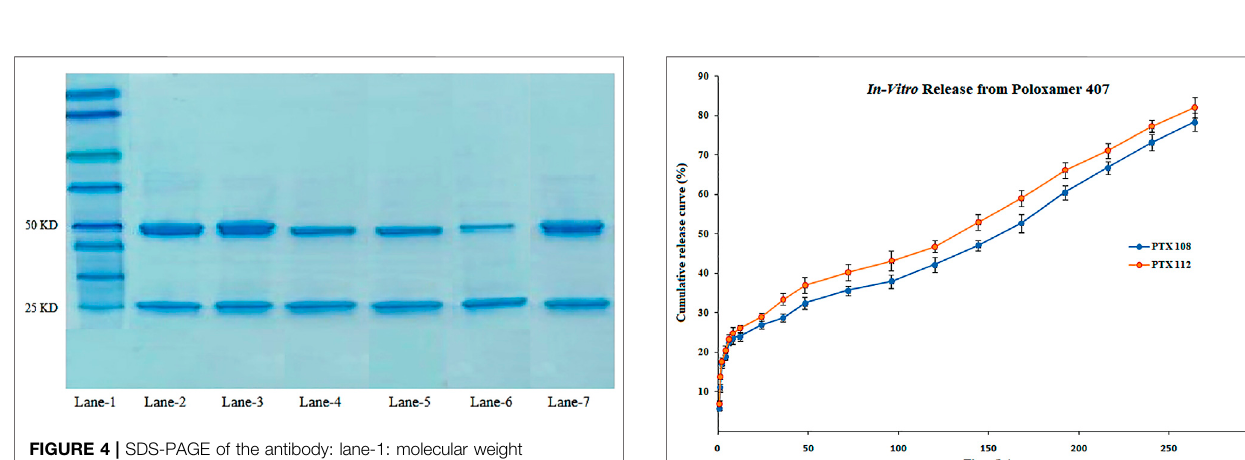
Frontiers in Pharmacology |